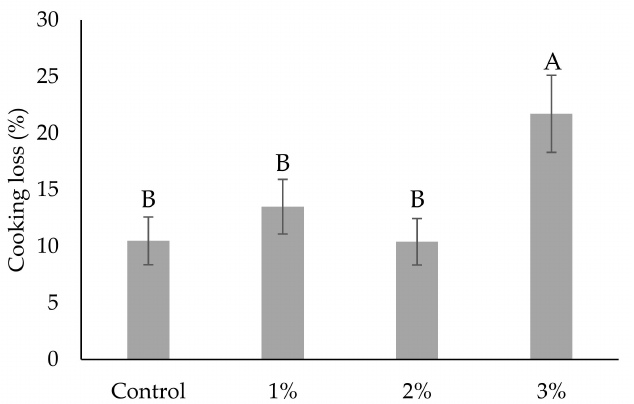
Figure 1. Cooking loss of fish sausages without (control) and with 1%, 2%, and 3% ( w / w ) of onion peel powder. A,B Bars, representing means ( n = 3), with di ff erent letters di ff er significantly ( p <